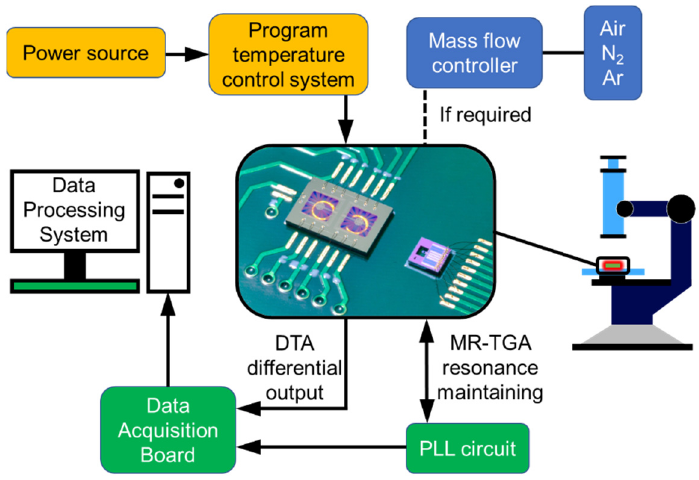
Figure 6. Schematic setup of the TG/DTA joint-characterization microsystem.